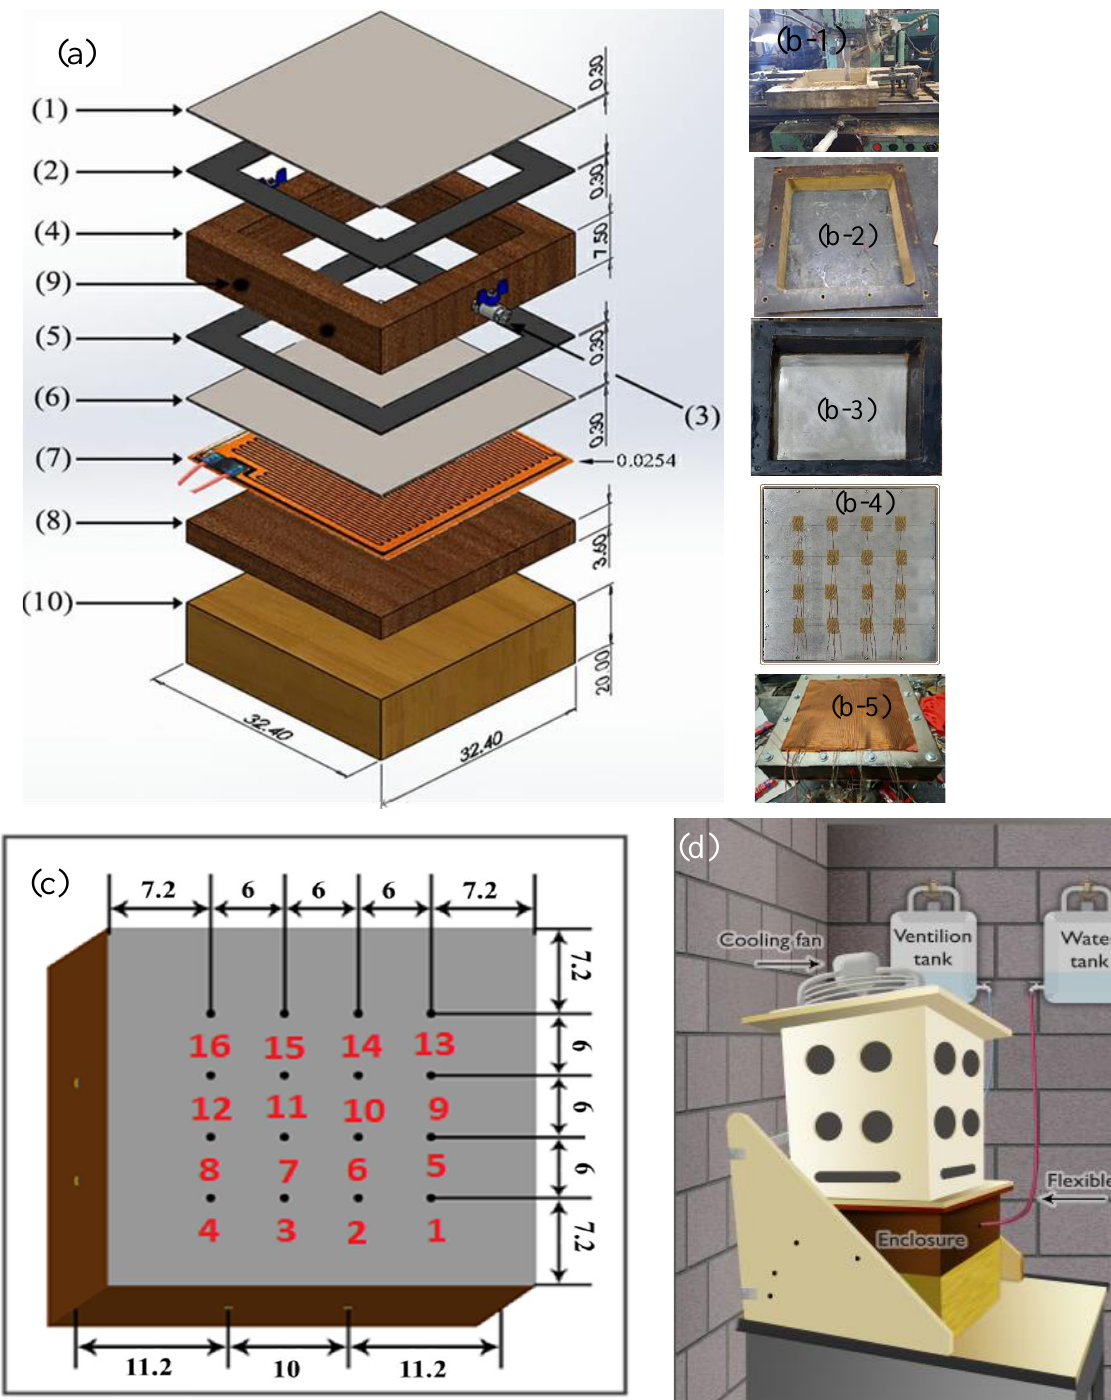
Figure 1. Enclosure setup: ( a ) components—(1) top surface (stainless), (2) sealing gasket, (3) valve (two-way), (4) sidewalls, (5) sealing gasket, (6) bottom surface (stainless), (7) heater, (8) Bakelite surface, (9) thermocouples, and (10) insulation cover; ( b ) real photos of the manufacturing and assembling of the enclosure; ( c ) thermocouple locations (dimensions are in cm); ( d ) complete setup.